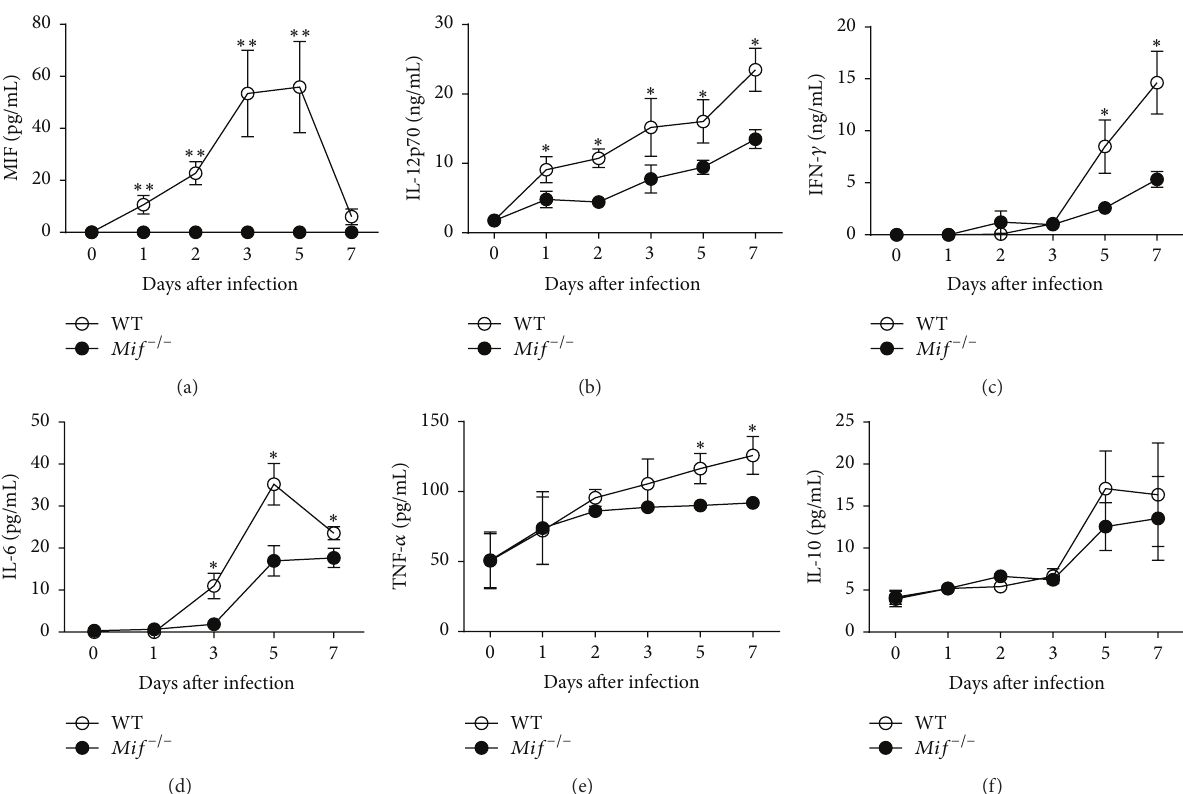
Figure 1: Serum MIF increases during acute T. gondii infection and regulates the production of proinflammatory cytokines. WT ( I ) and Mif −/− ( e ) mice were bled at various time points after infection with 100 cysts from ME49 strain. The serum was analyzed for cytokine concentrations by a Bio-Plex Pro Assay, Cytometric Bead Array (CBA), or MIF ELISA Kit. Data represent serum concentrations of MIF (a), IL-12p40 (b), IFN- 𝛾 (c), IL-6 (d), TNF- 𝛼 (e), and IL-10 (f) through the course of infection from 2-3 independent experiments ( 𝑛 = 3–5 at each time point). Data are presented as the mean ± SE. ∗ 𝑃 < 0.05